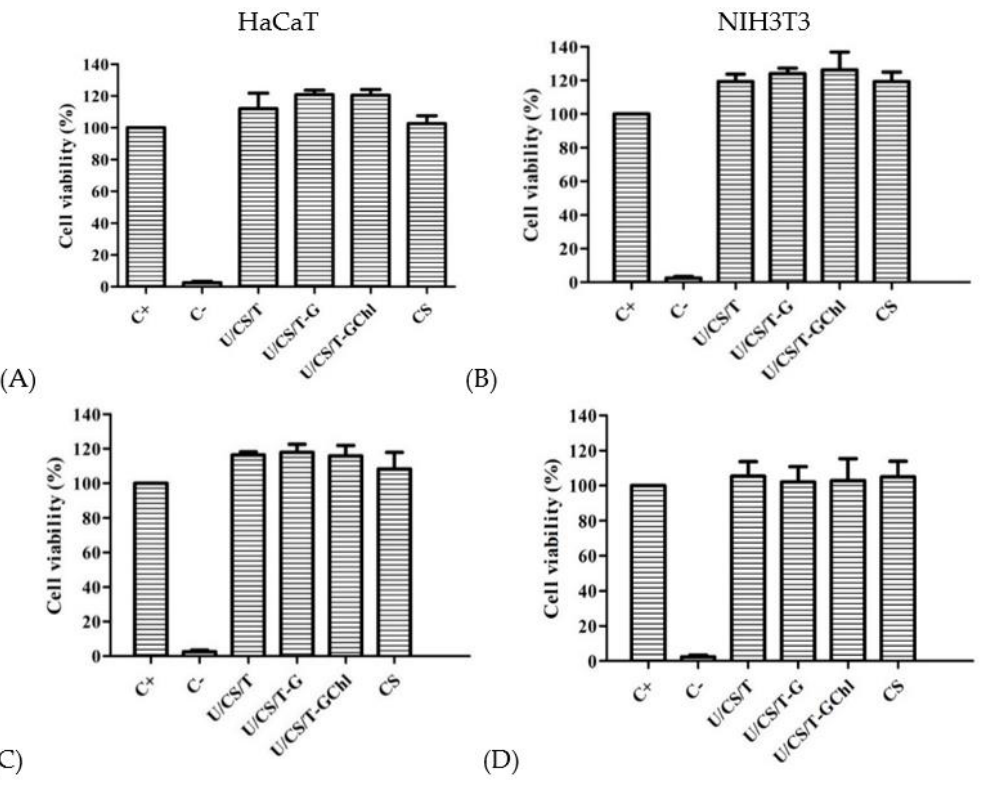
Figure 4. Cell viability of HaCaT cells treated with the ulvan/chitosan complex films ( A ), and their released media ( B ); cell viability of NIH 3T3 cells treated with the ulvan/chitosan complex films ( C ), and their release media ( D ). All the complex films had the same composition of U/CS/T at 20/75/5. Data were represented by the mean ± SD, n = 3. Positive control (C+) is culturing medium, Negative control (C − ) is 10% DMSO in medium.